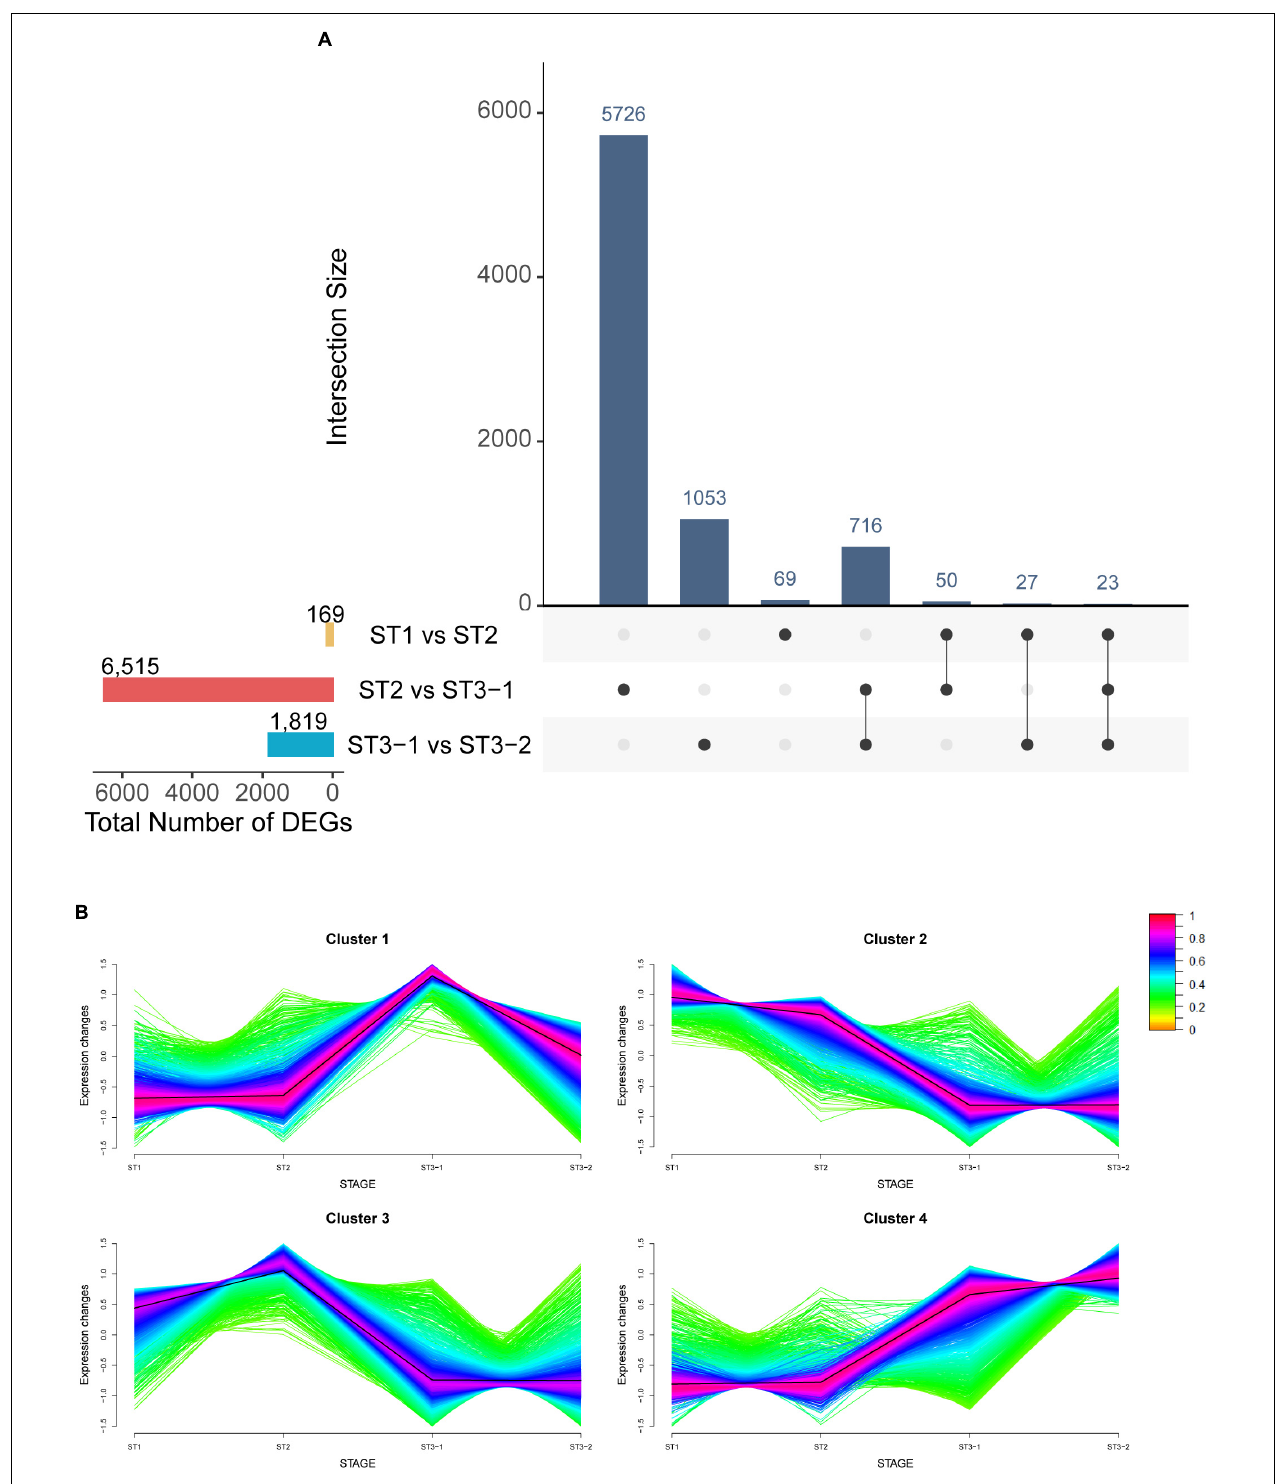
FIGURE 2 | Characteristics of genes during the early differentiation of female strobilus buds in ginkgo. (A) The UpsetR plot shows the differentially expressed genes (DEGs) (|log 2 FC| > 1; adjusted p -value < 0.05) between the vegetative (ST1) and the initial differentiation (ST2) stages, the initial differentiation (ST2), and the early exuberant differentiation (ST3-1) stages, the early exuberant differentiation (ST3-1) and the late exuberant differentiation (ST3-2) stages. (B) The fuzzy C-means clustering identified four distinct temporal patterns of DEGs. The x -axis represents the differentiation stages of ginkgo female strobilus buds, while the y -axis represents the normalized expression changes in each stage.